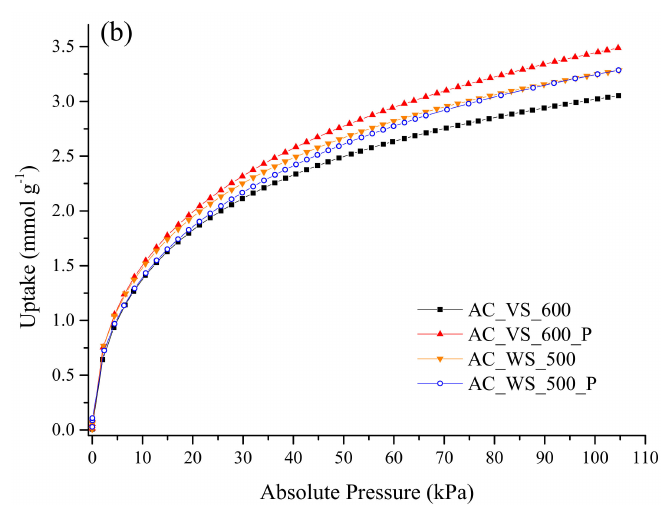
Figure 2. Adsorption isotherms of N 2 at –196 ◦ C ( a ) and CO 2 at 0 ◦ C ( b ) on the activated biochars (see Table 1 for sample designation).